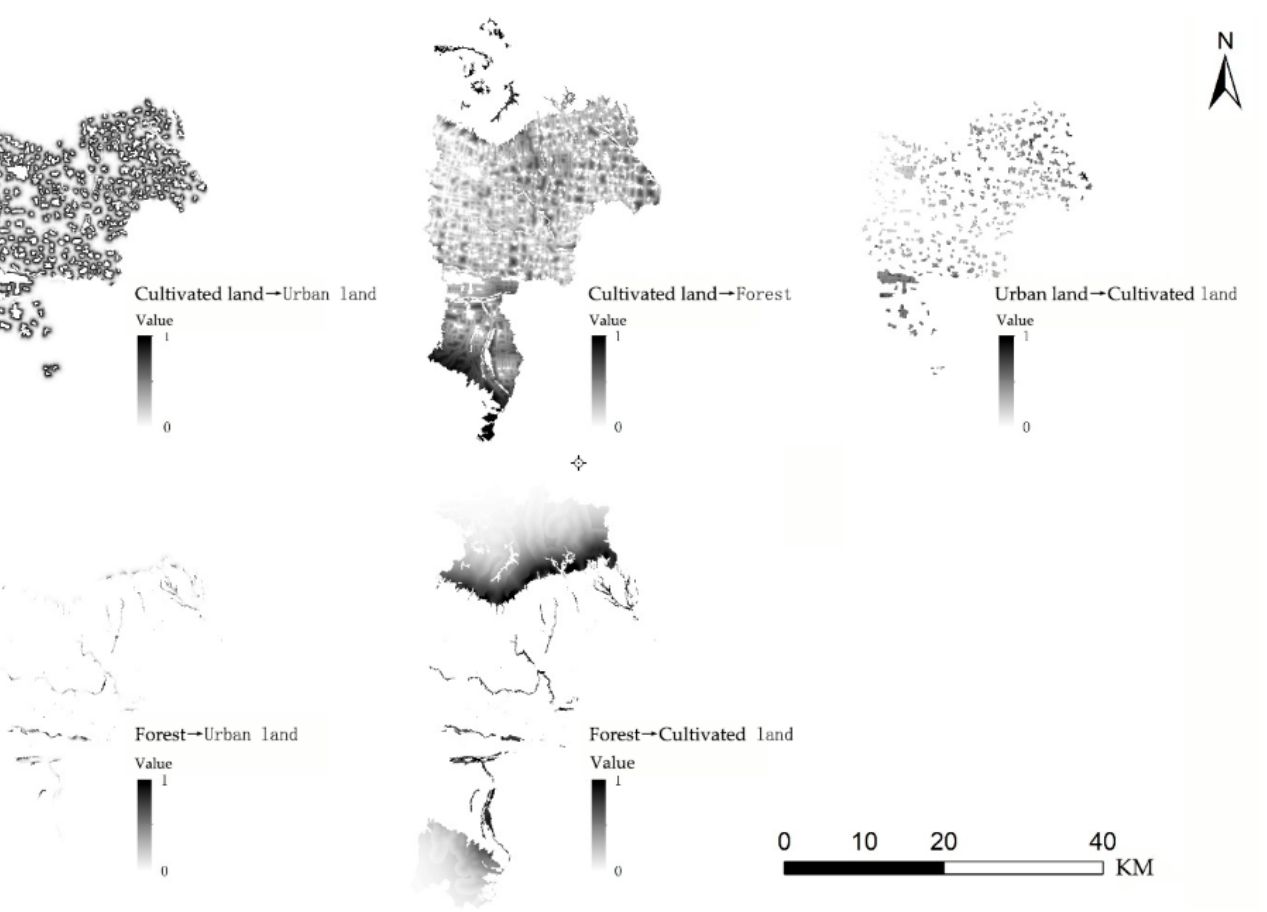
Figure 7. Transition probability for each land use type in LCM model establishment.